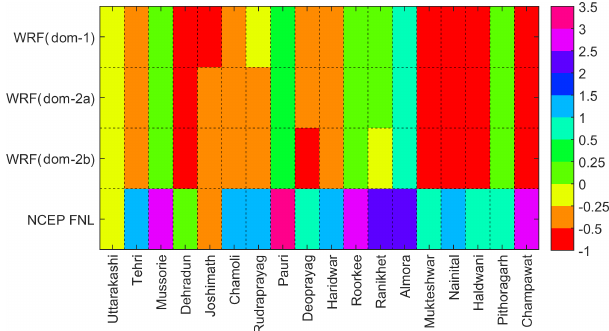
Figure 12. Bias ( β) in rainfall simulations obtained from the NCEP FNL and WRF (upscaled to 1 ◦ × 1 ◦ )